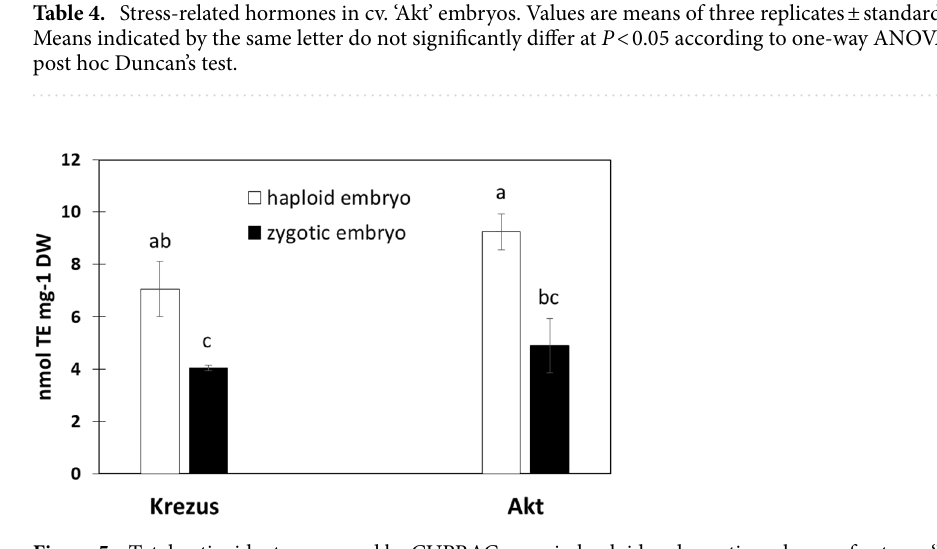
Figure 5. Total antioxidants measured by CUPRAC assay in haploid and zygotic embryos of oat cvs. ‘Krezus’ and ‘Akt’. Values expressed as Trolox equivalents. Different letters indicate statistically significant differences at P < 0.05 according to two-way ANOVA and post hoc Duncan’s